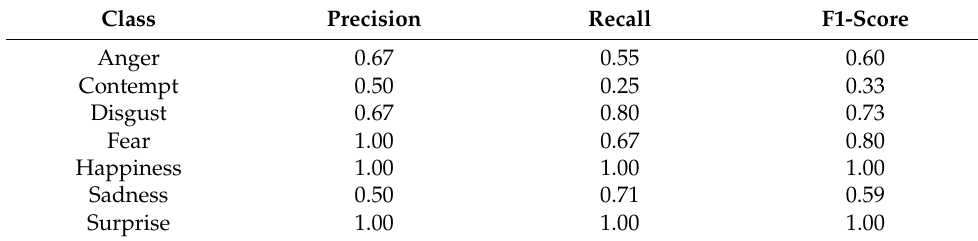
Table 14. SVM training results for iteration 4 of K-fold stratified using dataset2 .